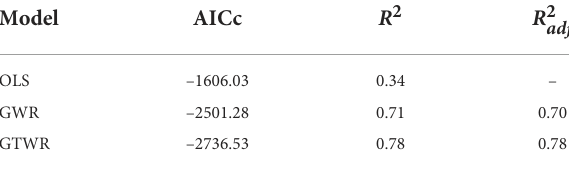
TABLE 4 Result of accuracy evaluation of different